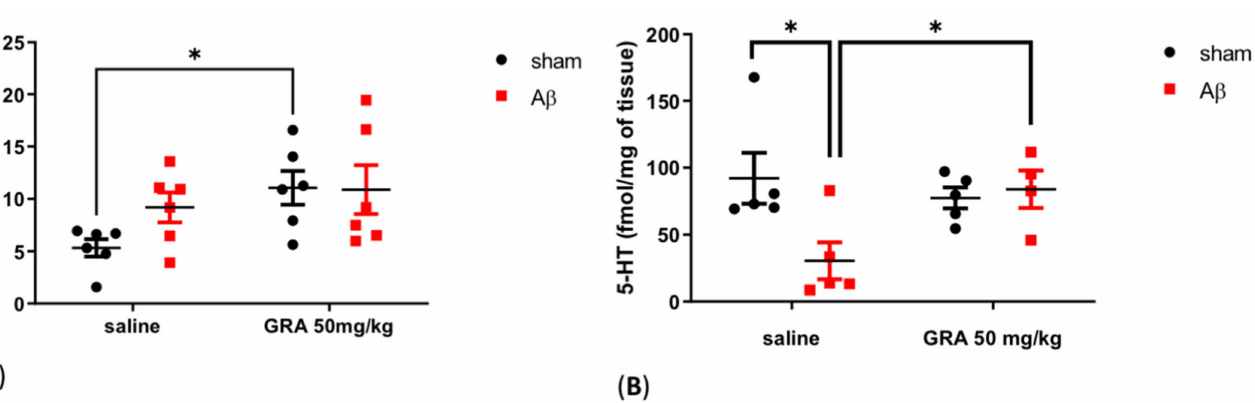
Figure 4. Effect of GRA administration on cortical monoamine quantifications in sA β -1-42-treated rats. Effect of GRA (50 mg/kg) administration on cortical NA (( A ), n = 6 per group) and 5-HT (( B ), saline sham n = 5, saline sA β 1-42 n = 5, GRA sham n = 5 and GRA sA β 1-42 n = 4) in rats 7 days after i.c.v. injection of vehicle (sham, 5 µ L, black dots) or A β (A β , 4 µ M, red dots). * p < 0.05 GRA sham vs. saline sham; * p < 0.05 saline sA β 1-42 vs. saline sham; * p < 0.05 GRA sA β 1-42 vs. saline sA β 1-42. Two-way ANOVA followed by Bonferroni’s post hoc